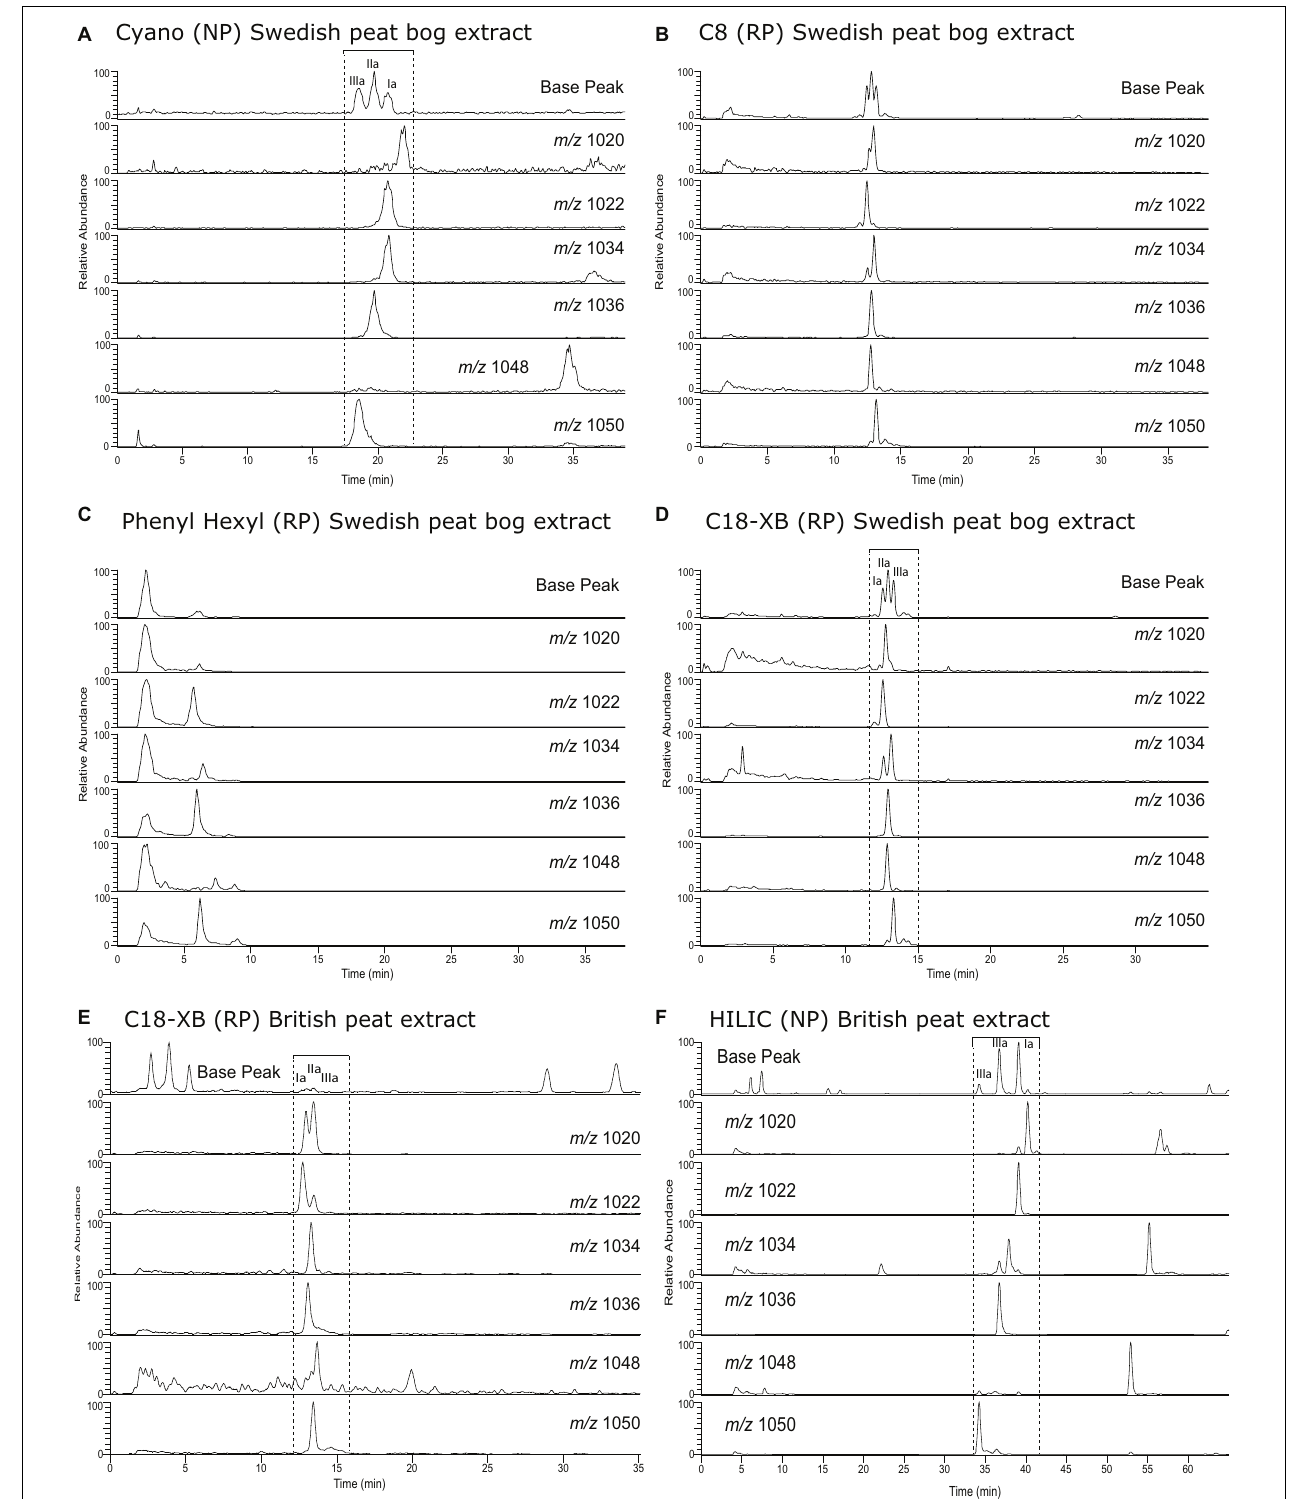
FIGURE 3 | Base peak and selected ion monitoring chromatogram of branched GDGTs from a two peat bog extracts. The Swedish peat extract was analyzed using (A) cyano, NP; (B) C8, RP; (C) phenyl hexyl, RP; (D) C18-XB, RP. A British peat extract analyzed was more recently analyzed using C18-XB and HILIC (E,F) . Note the reverse order of the tetra (I), penta (II), and hexamethylated (III) GDGTs in NP and RP. Supplementary Figure S6B compares the chromatography of C18-XB and HILIC using the British peat extract.